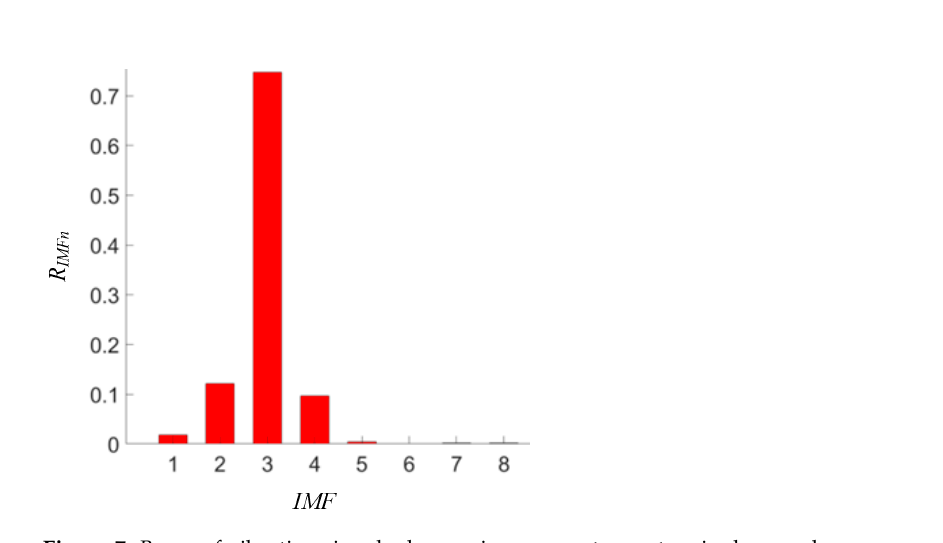
Figure 7. R IMFn of vibration signal when main pump rotor system is